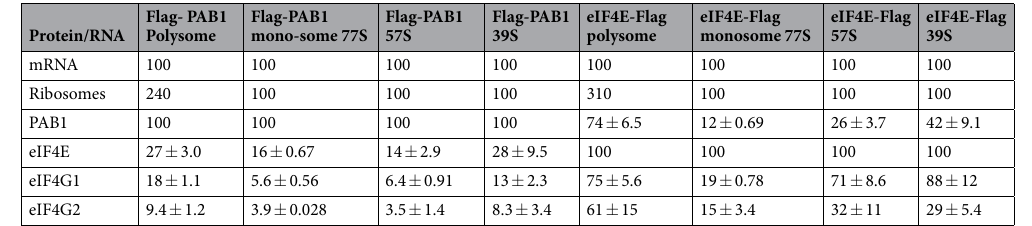
Table 2. Stoichiometric analysis of closed-loop factors in the 57S complex. Stoichiometric calculations were done as described 25 and as summarized in the text. All values are given relative to 100 mRNA bound by ribosomes. The number of ribosomes in polysomal material was determined as described 25 . Values represent at least three to seven separate determinations. Yeast contain two eIF4G isomers and data is given for